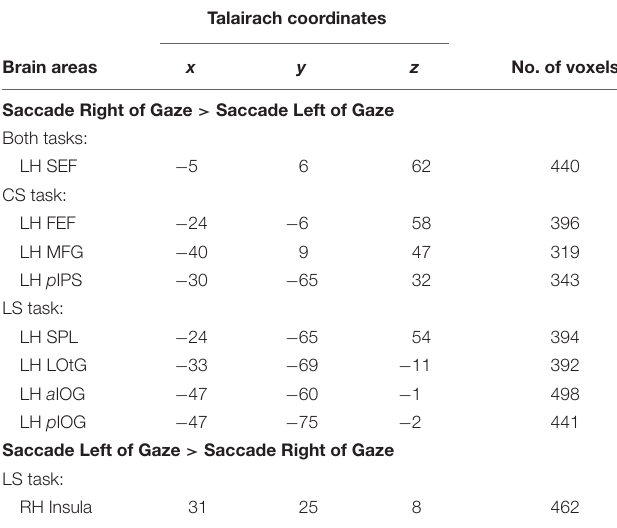
TABLE 5 | Talairach coordinates and number of voxels for contrast no.